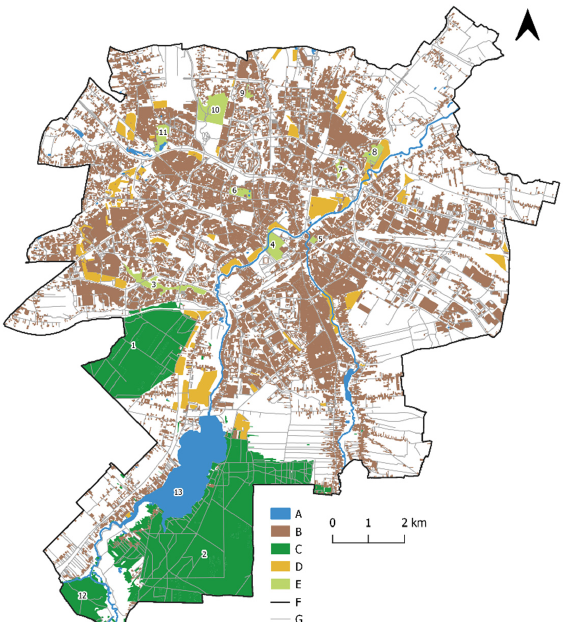
Figure 2. Selected recreation areas in Lublin. (A) surface water; (B) built-up areas; (C) woodland; (D) allotment gardens; (E) parks; (F) city boundary; (G) roads; (1) Stary Gaj forest; (2) D ˛abrowa forest; (3) John Paul II Park; (4) Ludowy Park; (5) Bronowice Park; (6) Saxon Gardens; (7) Kalinowszczyzna gully; (8) Zawilcowa Park; (9) Czechow Park; (10) Górki Czechowskie Park; (11) MCSU Botanical Gardens; (12) Rudki forest; (13) Lake Zemborzycki (source: own elaboration based on [87,88]).